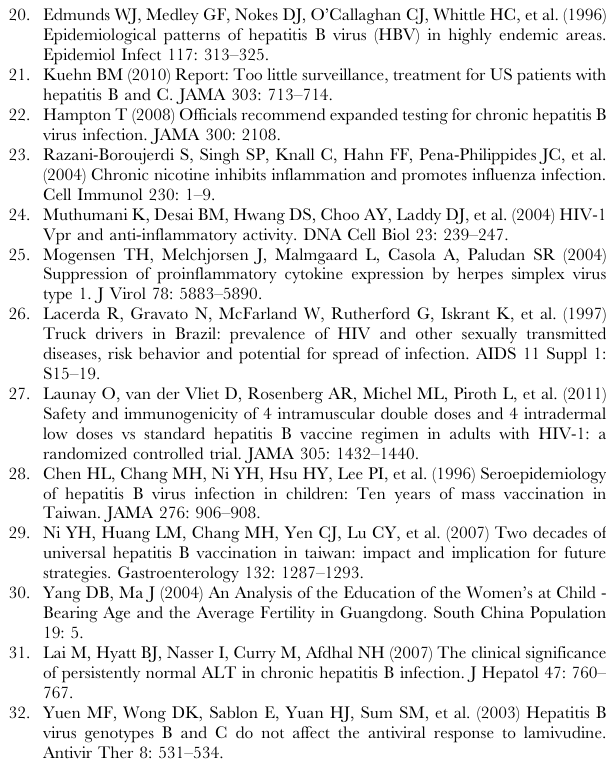
Table S1 The formula for the reduced number of CHB, cirrhosis and HCC, the cost of the treatment, and the money saved. Table S2 Influencing factors on the prevalence of suspected hepatitis B for ages from 20–60 years. Table S3 Cost and benefit analysis for the 1992 and 2011 intervention plan for hepatitis B. Table S4 Prediction of HBsAg carrier rate in the